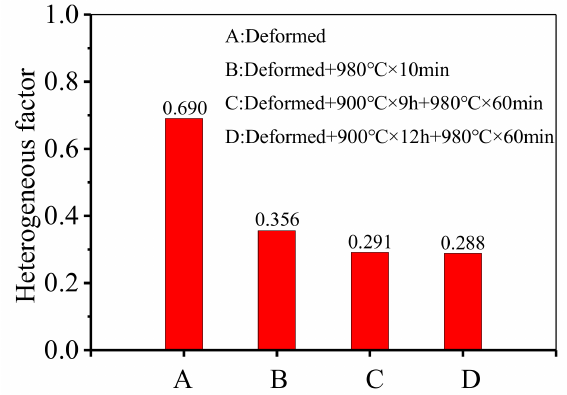
Figure 11. Heterogeneous factor (HF) after different annealing